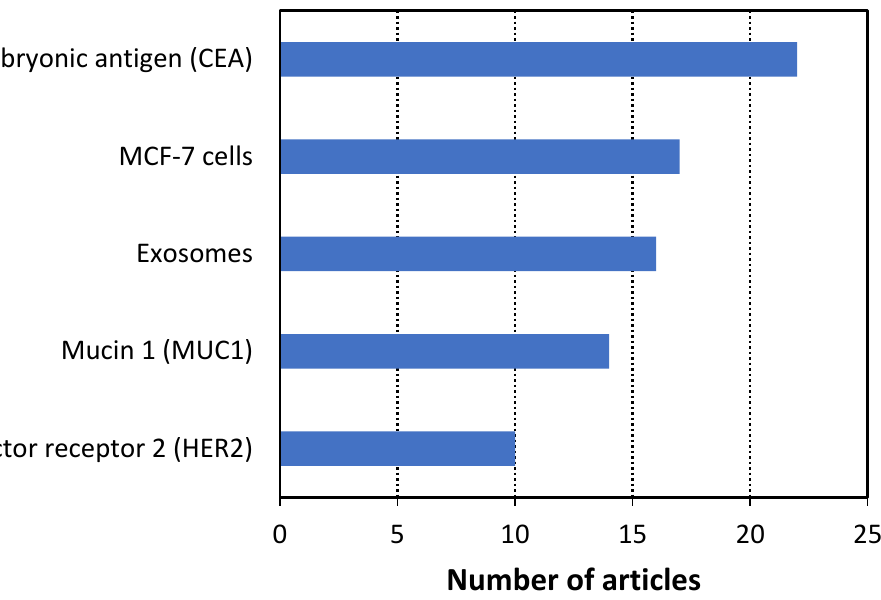
Figure 12. Histogram of the five most studied biomarkers for cancer detection using the three biorecognition technologies.